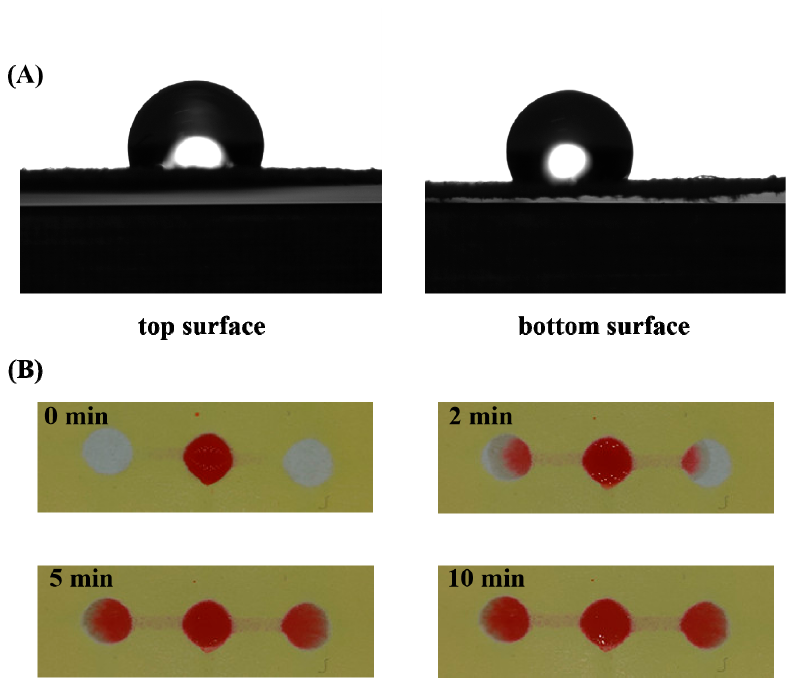
Figure 4. The intersection of the 3D sl- µ PADs captured under an optical microscope.